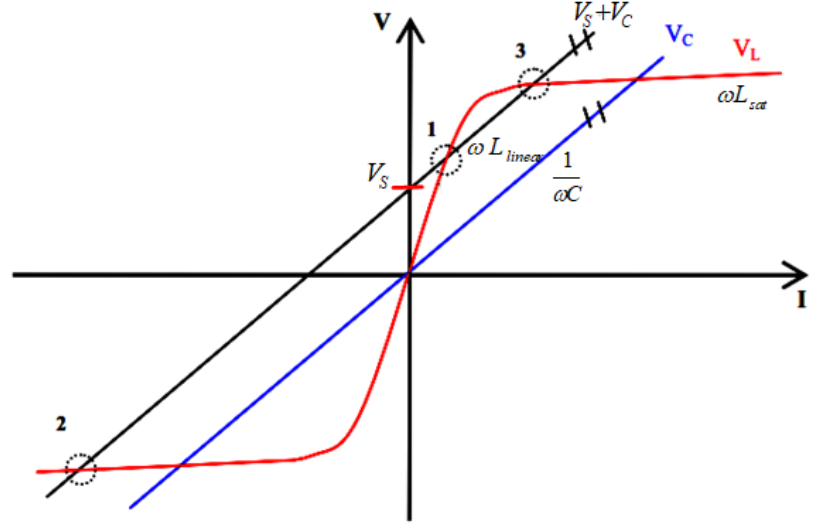
Figure 5. The graphical solution of a series ferroresonance circuit [33].